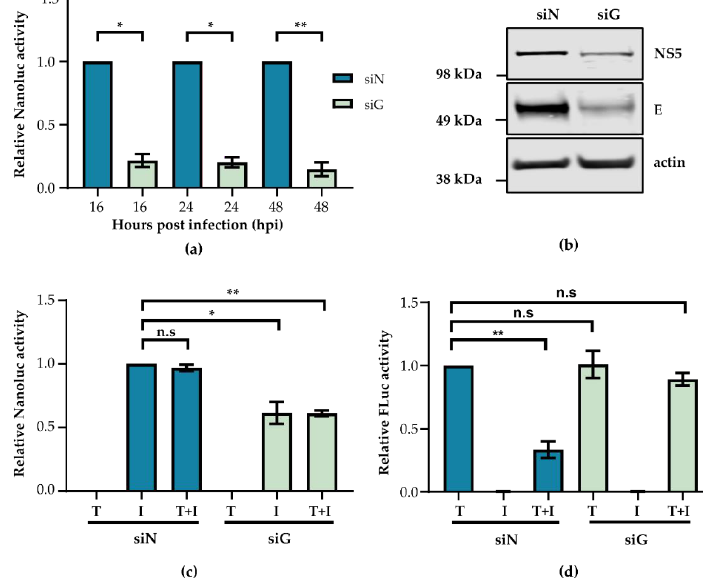
Figure 4. GRP78 depletion reduces ZIKV translation. A549 cells were treated with siN or siG for 72 h. ( a ) Cells were infected with ZIKV-Nanoluc at a MOI 0.1 before cells were lysed and Nanoluc levels were measured at 16, 24, or 48 hpi and normalised to each timepoint separately. ( b ) A549 cells were infected with ZIKV PE243 at MOI 10 for 24 h following siRNA treatment. A representative blot of triplicate experiments is shown detecting ZIKV NS5 and E with actin as loading control. ( c , d ) Following siRNA treatment, cells were either transfected with 100 ng of pGL4.13 FLuc expressing plasmid (labelled ‘T’), infected with Nanoluc at MOI 5 (labelled ‘I’) or both (labelled ‘T + I’). Cells were lysed, and ( c ) Nanoluc readings or ( d ) FLuc readings were measured. ZIKV-Nanoluc readings are relative to siN ‘I’, while FLuc readings are normalised to siN ‘T’. Experiments were performed in triplicate, and the mean and the standard error of the mean are plotted. An unpaired Student’s t -test with Welch’s correction was used to determine statistical significance where n.s = not significant, * p -value < 0.05, ** p -value <